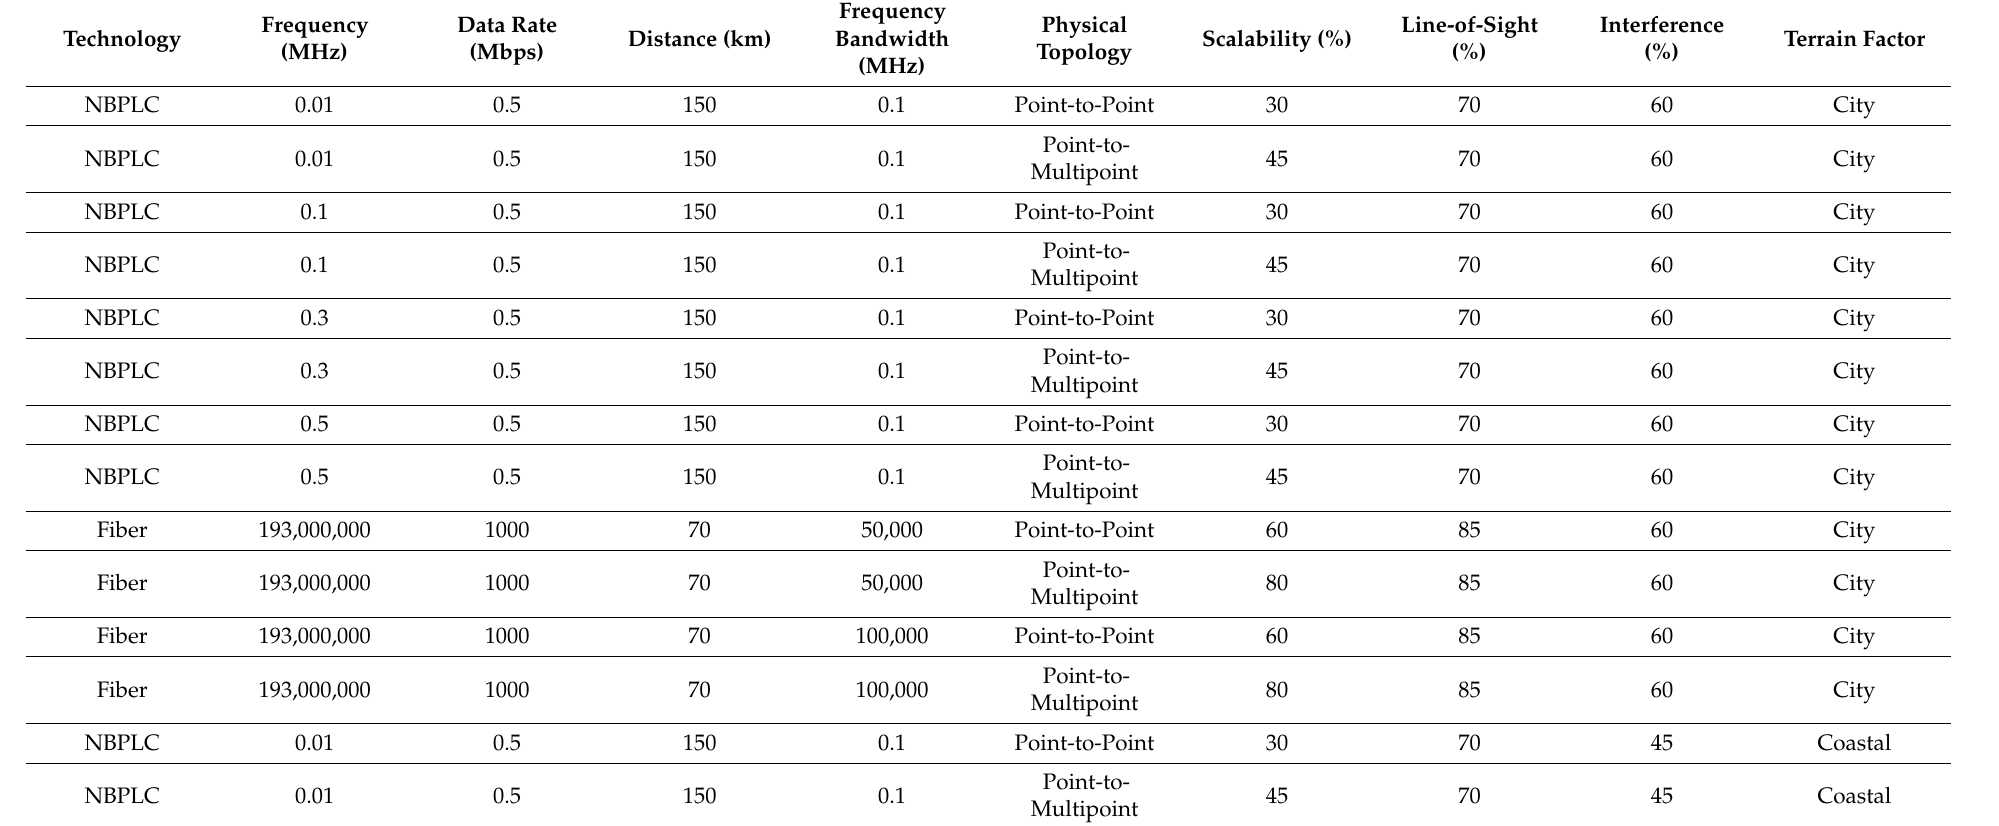
Table 2. The visualization of the training dataset in Microsoft